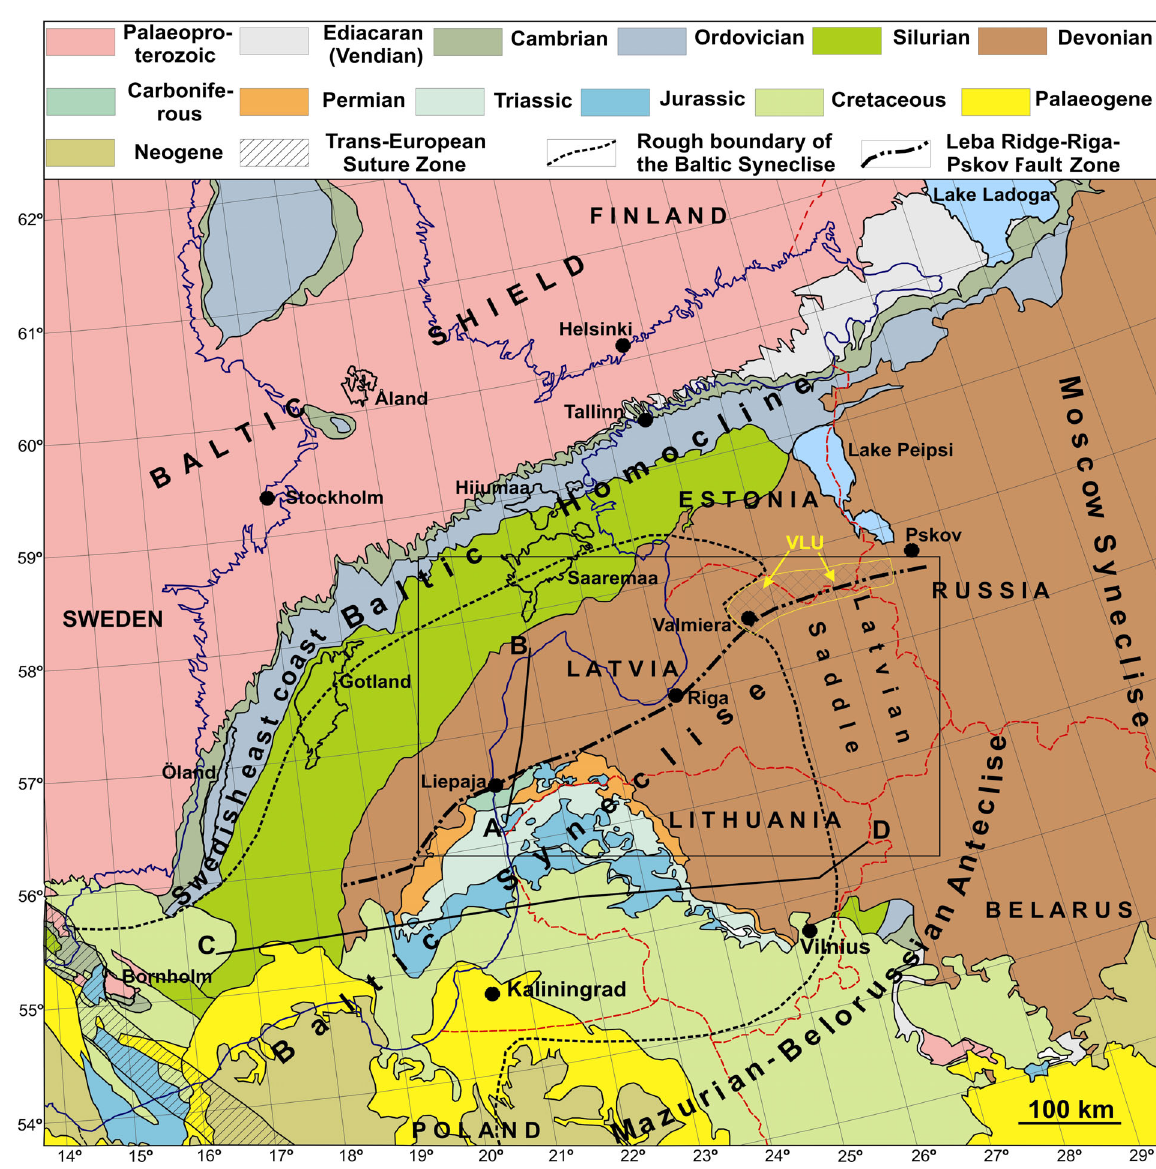
Fig. 1. Geological map of the NW East European Platform showing major platform structures discussed in text with structural setting of the Leba Ridge–Riga–Pskov Fault Zone, a frame of the map shown in Fig. 15 and sites of the geological cross sections A–B and C–D shown in Figs 4 and 5, respectively. VLU – Valmiera–Lokno